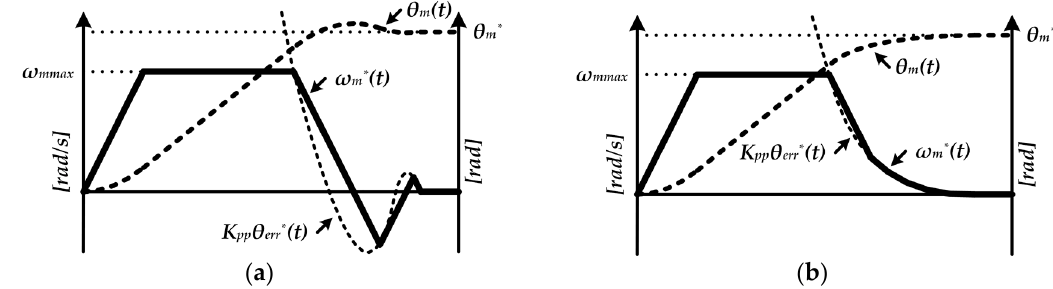
Figure 4. A velocity and position profiles generated by the dynamic range limiter: ( a ) a fast output change of the position controller; ( b ) a slow output change of the position controller.